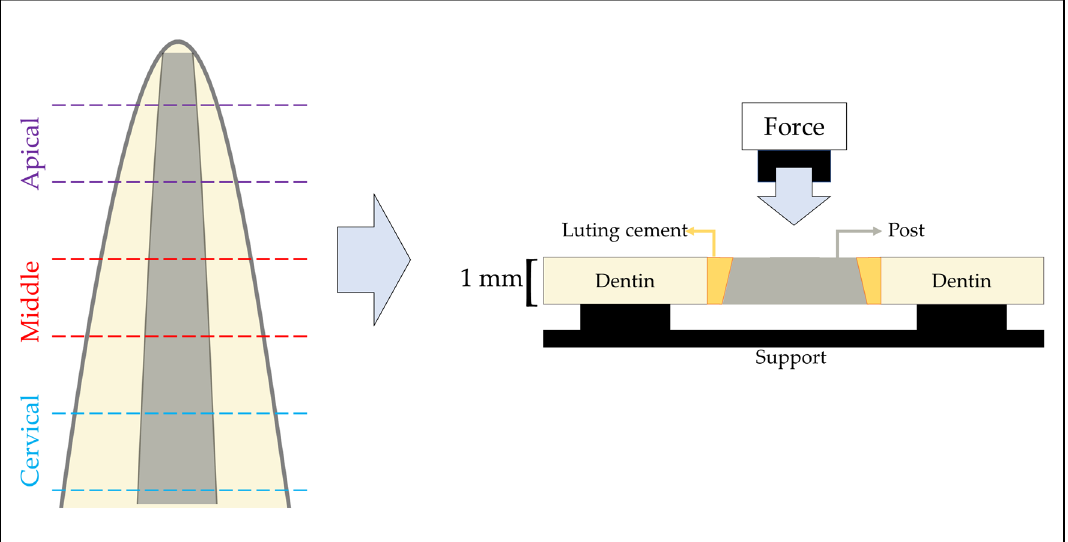
Figure 2. Distribution of the root slices with six 1-mm-thick slices (two per third) obtained from each root sample. Diagram of the push-out test procedure on the tooth slices.